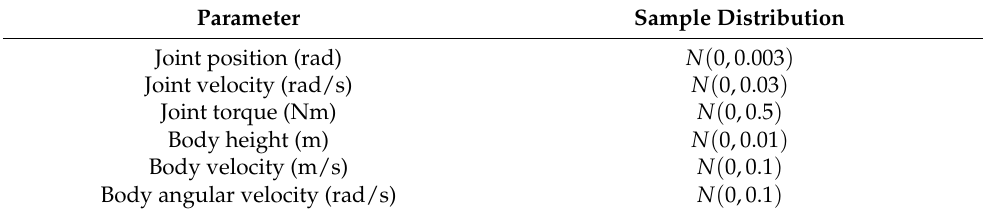
Table 4. Sensor noise sampling parameters.